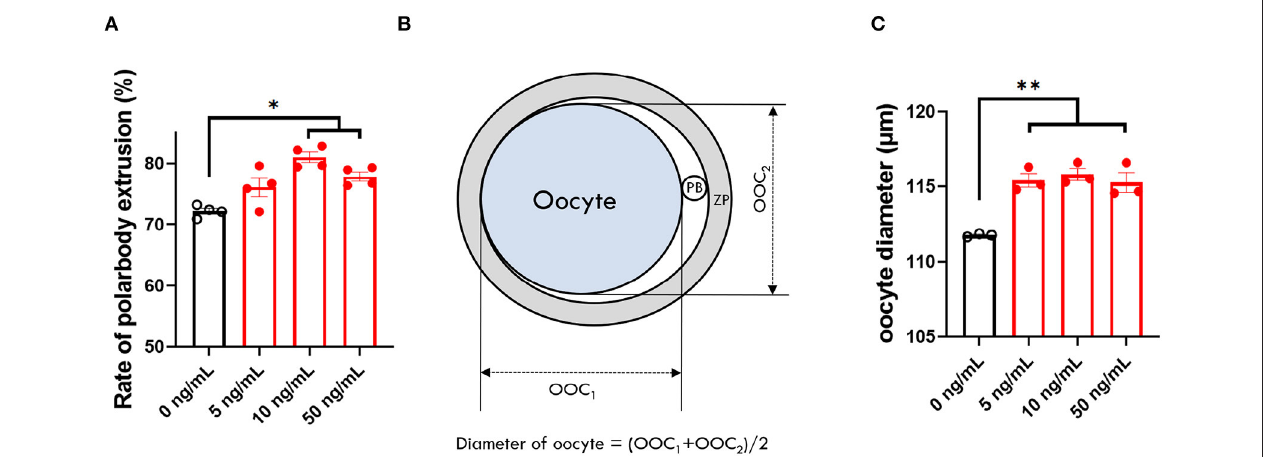
FIGURE 2 | Effect of stem cell factor (SCF) supplementation during in vitro maturation (IVM) on nuclear maturation and size of porcine oocytes. (A) Quantified rate of polar body extrusion after 42h of IVM supplemented with various concentrations of SCF. (B) A diagram of the measurement of porcine oocyte diameter after IVM modified from Figure 3 of Lee et al. ( 24). ZP, zona pellucida. PB, polar body. (C) Quantified diameter of mature porcine oocytes after 42h of IVM supplemented with various concentrations of SCF. For all graphs, the value represents the mean ± SEM. Asterisks indicate statistical significance (* p < 0.05 and ** p < 0.01). Statistical significance was determined by one-way ANOVA. The experiments were repeated three or four